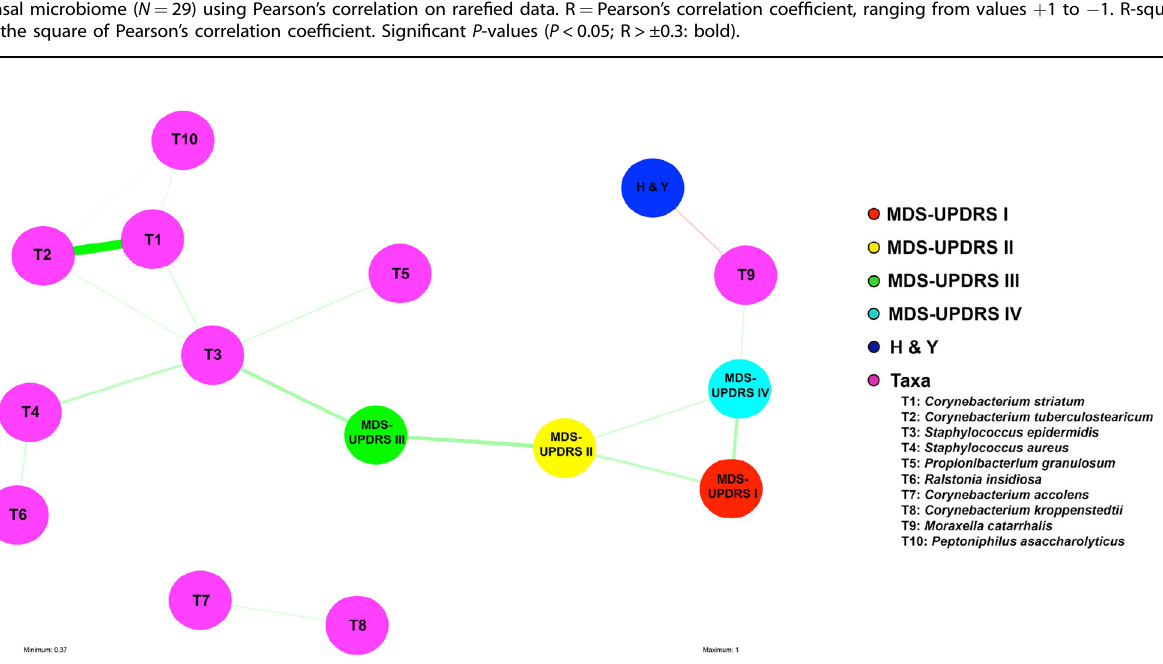
Fig. 4 Multivariate analysis of bacterial species and PD clinical features. Visualization of multiple associations present in clinical features of PD subjects with deep nasal microbiota data using a multivariate network analysis of bacteria (species) in the deep nasal sinus of PD subjects ( n = 29) and PD clinical characteristics. Positive correlations (green arrows), negative correlations (red arrows), strong (thick edges) and weak (thin edges, less saturated) correlations between PD subject clinical features and bacterial species are shown. Correlation arrows displayed are signi fi cant ( P < 0.05) and have R-values greater than